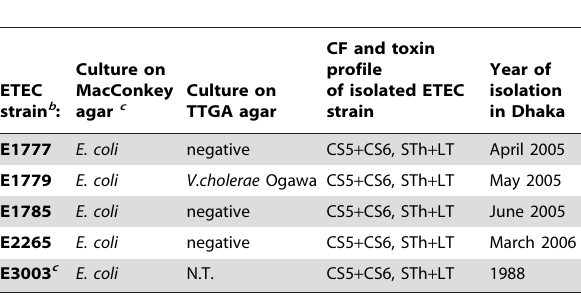
Table 1. Strains used in the study and results from culturing a of clinical stool